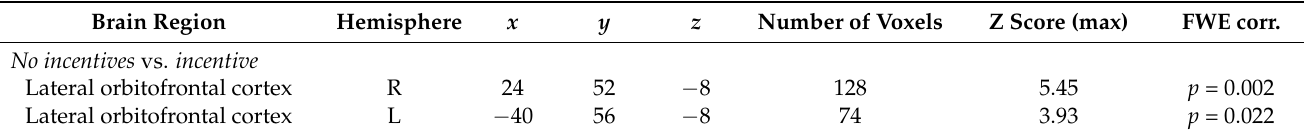
Table 1. Brain activations related to the anticipation model (GLM 1, time-locked to screen II). All reported activations survived a threshold of p < 0.05, family-wise error (FWE) corrected for multiple comparisons at the cluster level, with an underlying threshold corresponding to p < 0.001 uncorrected at the whole-brain level. Abbreviations: L/R: left/right; x , y and z : coordinates in Montreal Neurological Institute (MNI) space.